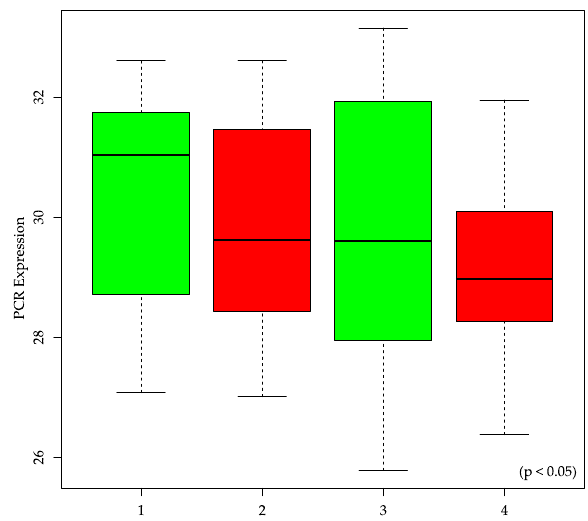
Figure 2. Correlation of miR-573 expression to tumor regression grade (TRG). A high tumor regression grade (TRG 4), which shows a good response to chemoradiotherapy (CRT), is significantly associated to a low expression of miR-573 ( p < 0.05). Patients with a high expression of miR-573 show a low response to CRT (TRG 1).